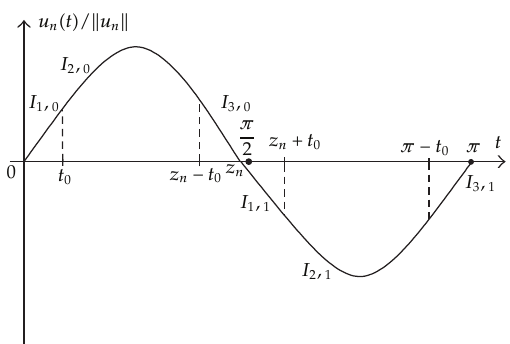
Figure 1: Solution of (cid:3) 1.3 (cid:4) near to the bifurcation point (cid:3) σ 2 , (cid:6) ∞ (cid:4)